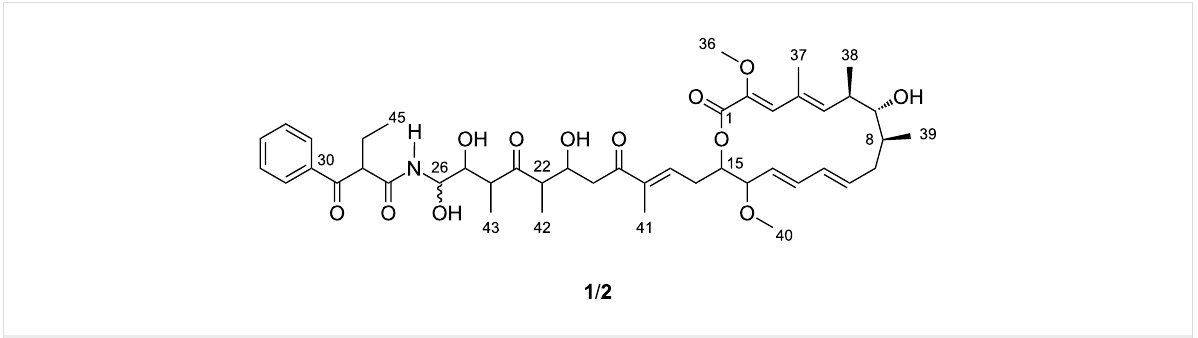
Figure 1: Lanyamycin ( 1 / 2 ), differing at C-26, isolated from Sorangium cellulosum (Soce